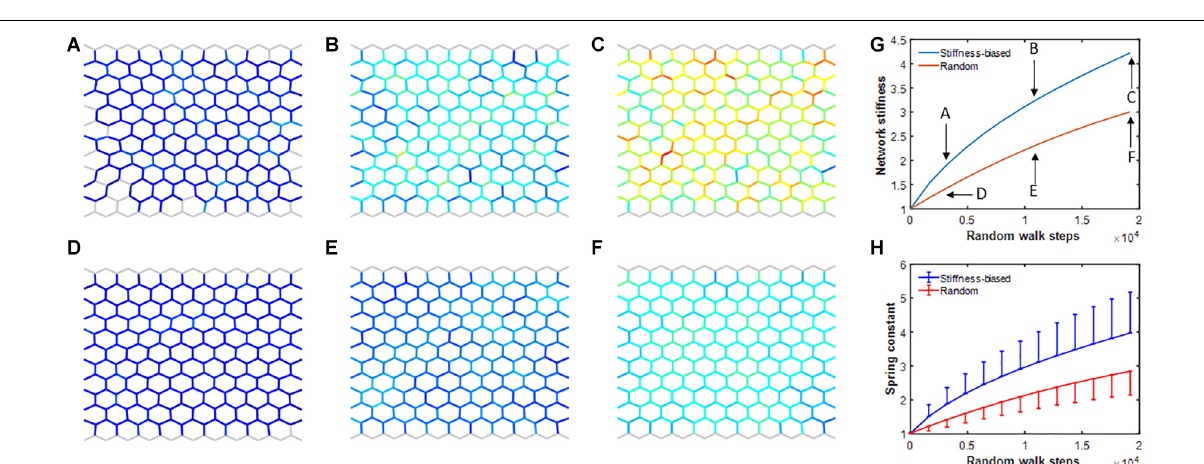
FIGURE 6 | Evolution of the halo cluster size relative to the size of the network given in percent for the stiffness-biased (b: solid lines) and pure random (r: dotted lines) walks. Different colors represent different number of agents within the network. There is a statistically significant difference between the biased and random curves everywhere except the for smallest random walk step number. Panel (A) shows the random walk steps on log scale and panel (B) shows the halo size on log scale after the peak.